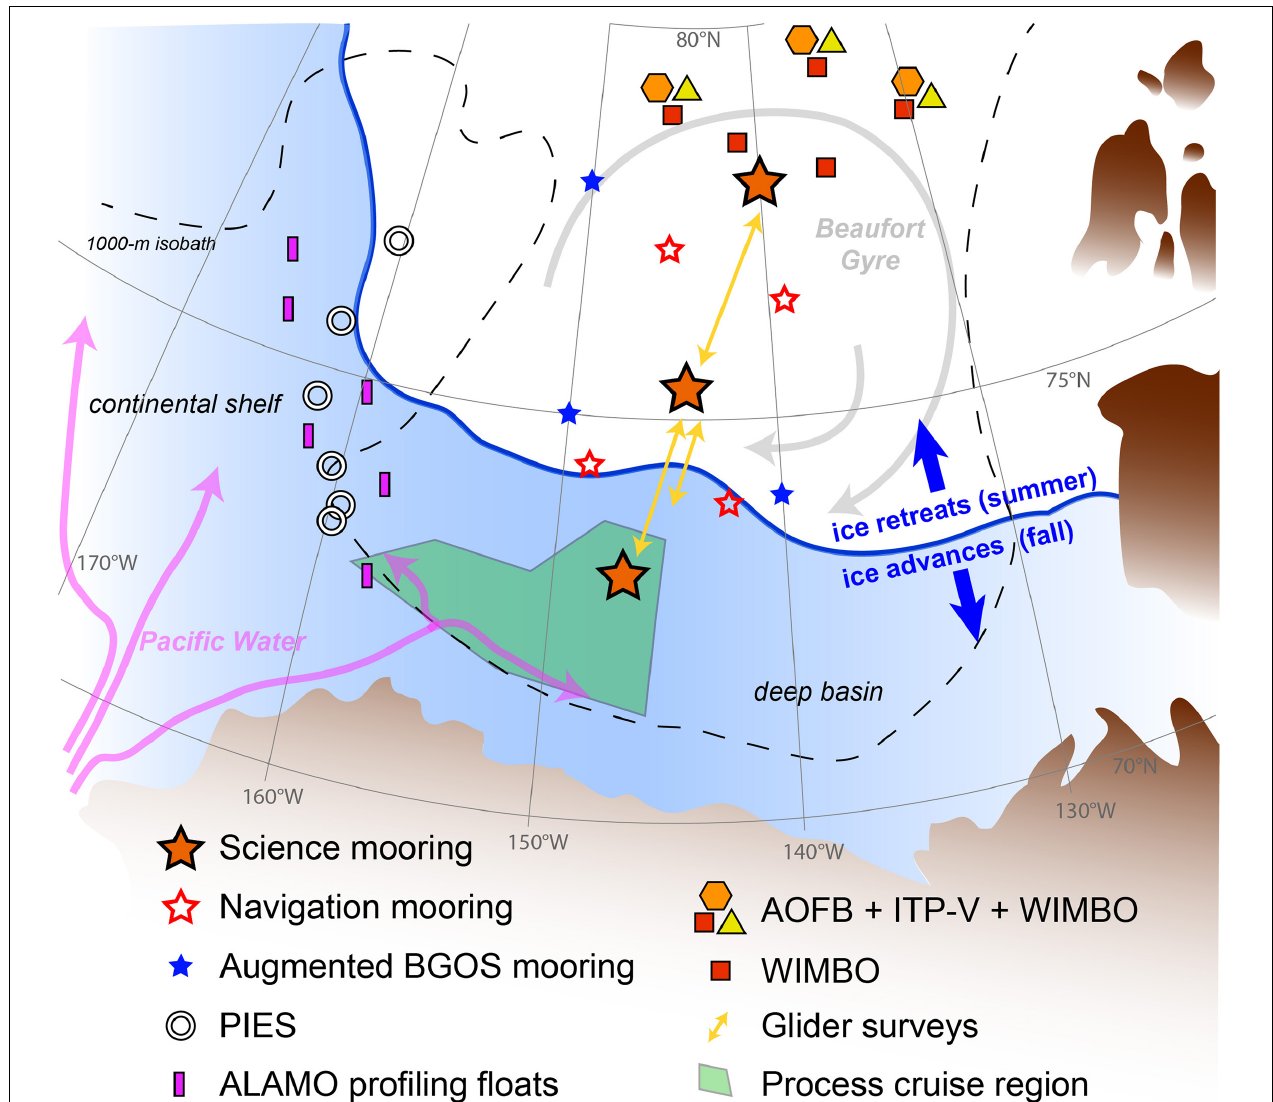
FIGURE 1 | Schematic map of the SODA observational assets. The orange hexagons (ITP-V), yellow triangles (AOFB) and red squares (WIMBO) mark instruments deployed directly onto sea ice. Note that there are 3 clusters that include all three instruments, plus two additional WIMBO sites. Science moorings (orange stars) are surrounded by acoustic navigation moorings (red stars), providing positional information for the gliders (yellow lines) when sampling under a canopy of sea ice. The Sikuliaq process cruise took place in the region highlighted in green. Healy deployed the moorings and ice instruments (up to 80 ◦ N). Argo and ALAMO floats (purple triangles) and PIES monitor circulation from the shelf to the deep